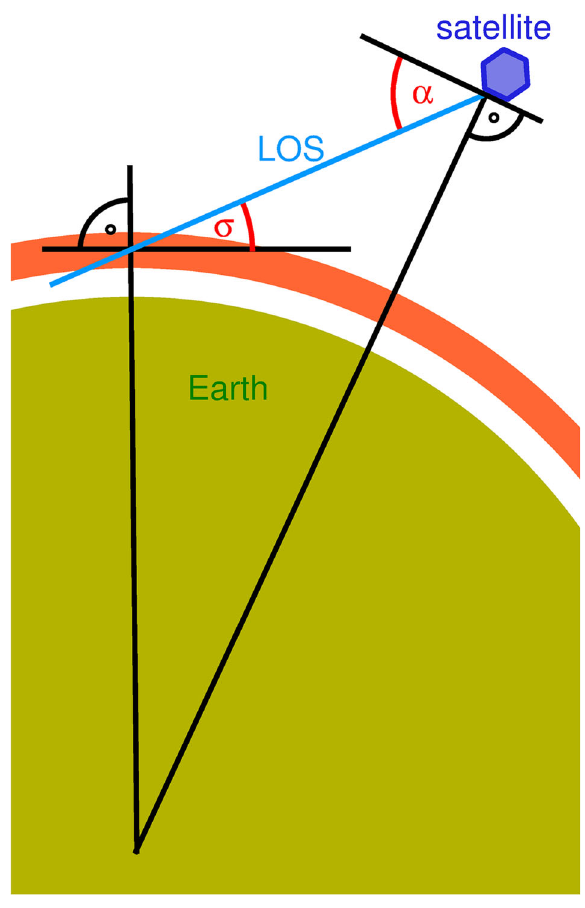
Fig. 1 Sketch of viewing geometry. From a position in orbit, the instrument views downward by an angle α below the local horizontal. Infrared thermal radiation is emitted from the saturation layer (indicated by the bright-red ring segment above the